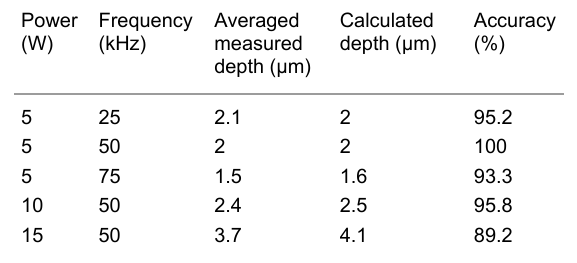
Table 2: Measured and calculated data for the ablation cross-section for Al coated